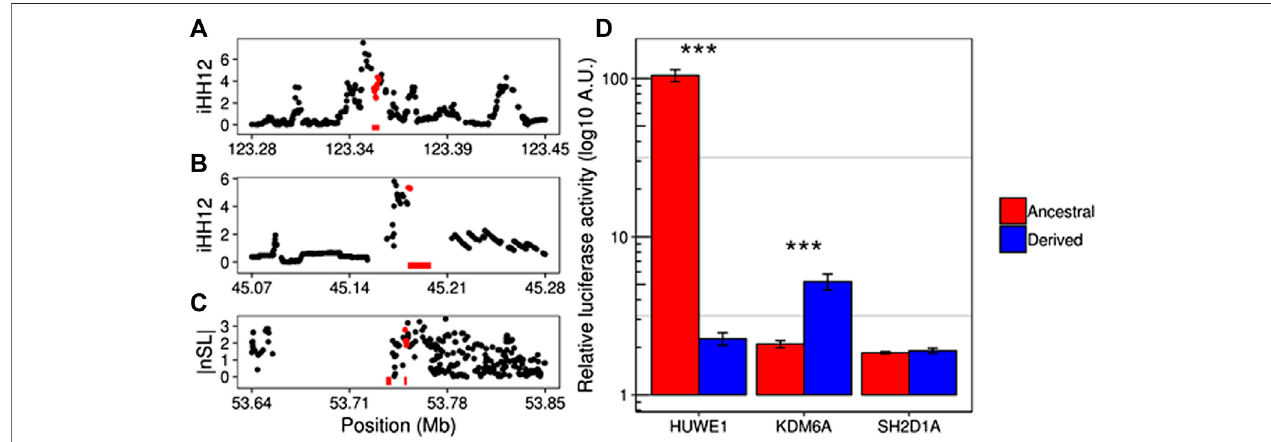
FIGURE3 | Candidate enhancers under putative positive selection. Manhattan plots show the selectionscoresoverlapping the enhancer coordinates (bottom red bars) targeting SH2D1A (A) , KDM6A (B) , and HUWE1 (C) genes in YRI, CEU, and YRI populations, respectively. Although HUWE1 appears under positive selection in Gambians (GWD) ( Supplementary Table S9 ), YRI individuals were used in the luciferase assay instead since the signal is also present in this population (99th percentile).ReddotscorrespondtoenhanceroverlappingSNPs. (D) Relativeluciferaseactivitycomparisonsbetweentheancestralandderivedhaplotypesineach of the candidate enhancers. Signi fi cant differential activities are seen in HUWE1 ( p (cid:1) 5.75e10 − 8 ) and KDM6A ( p (cid:1) 0.004) enhancers.